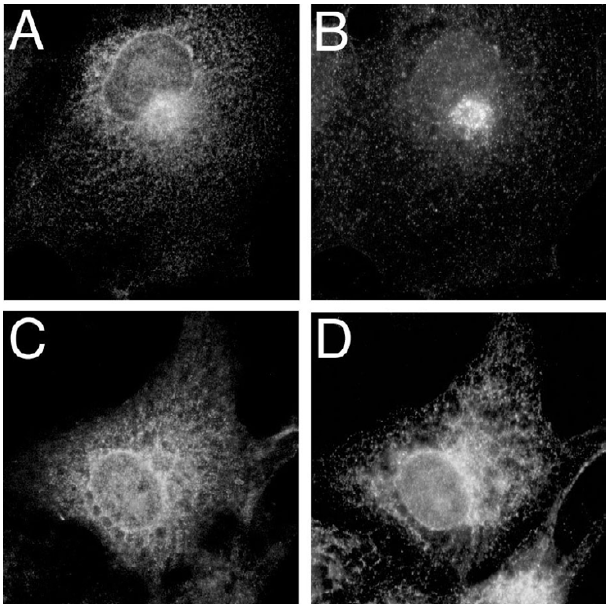
Figure 3 Localization of s α i2 to Golgi and ER membranes s α i2 was expressed in COS-7 cells. 48 h after transfection, cells on coverslips were fixed and processed for immunofluores- cence. Co-localization of s α i2 (A) and the Golgi protein, β - COP (B), was visualized after incubation of cells with the EE antibody and a rabbit polyclonal anti- β -COP antibody fol- lowed by Alexa 594 anti-mouse and Alexa 488 anti-rabbit antibodies. Co-localization of s α (C) and the endoplasmic i2 reticulum protein, protein disulfide isomerase (PDI) (D), was visualized after incubation of cells with the EE antibody and a rabbit polyclonal anti-PDI antibody followed by Alexa 594 anti-mouse and Alexa 488 anti-rabbit